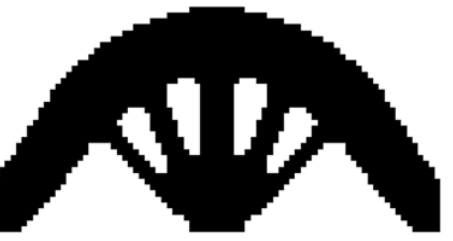
Figure 5. Optimized shape of simple bridge beam by traditional BESO.